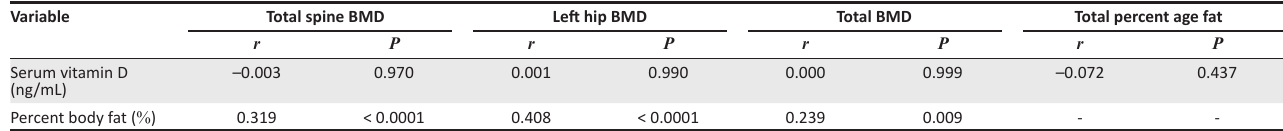
TABLE 2: Correlation between serum vitamin D, lifestyle, health and body composition variables: Pearson’s correlation between serum vitamin D and body composition variables.